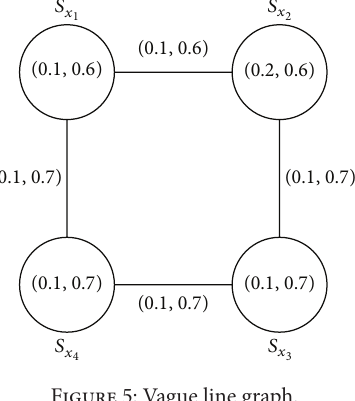
Figure 5: Vague line